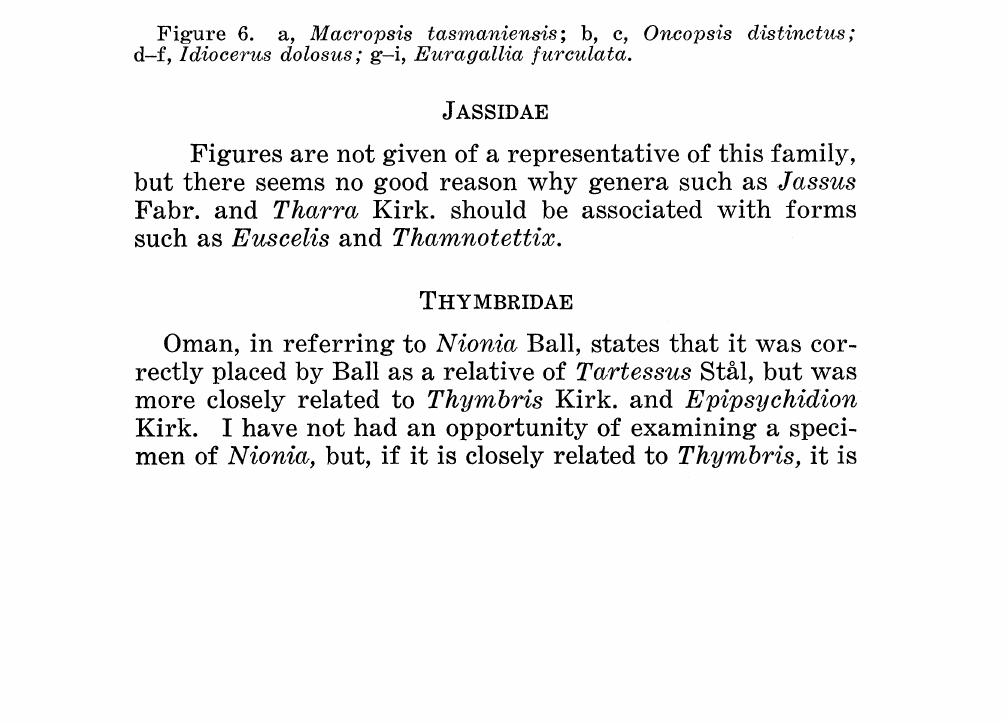
Figure 6. a, Macropsis tasnaniensis; b, c, Oncopsis distinctus; d-f, Idiocerus dolosus g-i, Euragallia furculata.